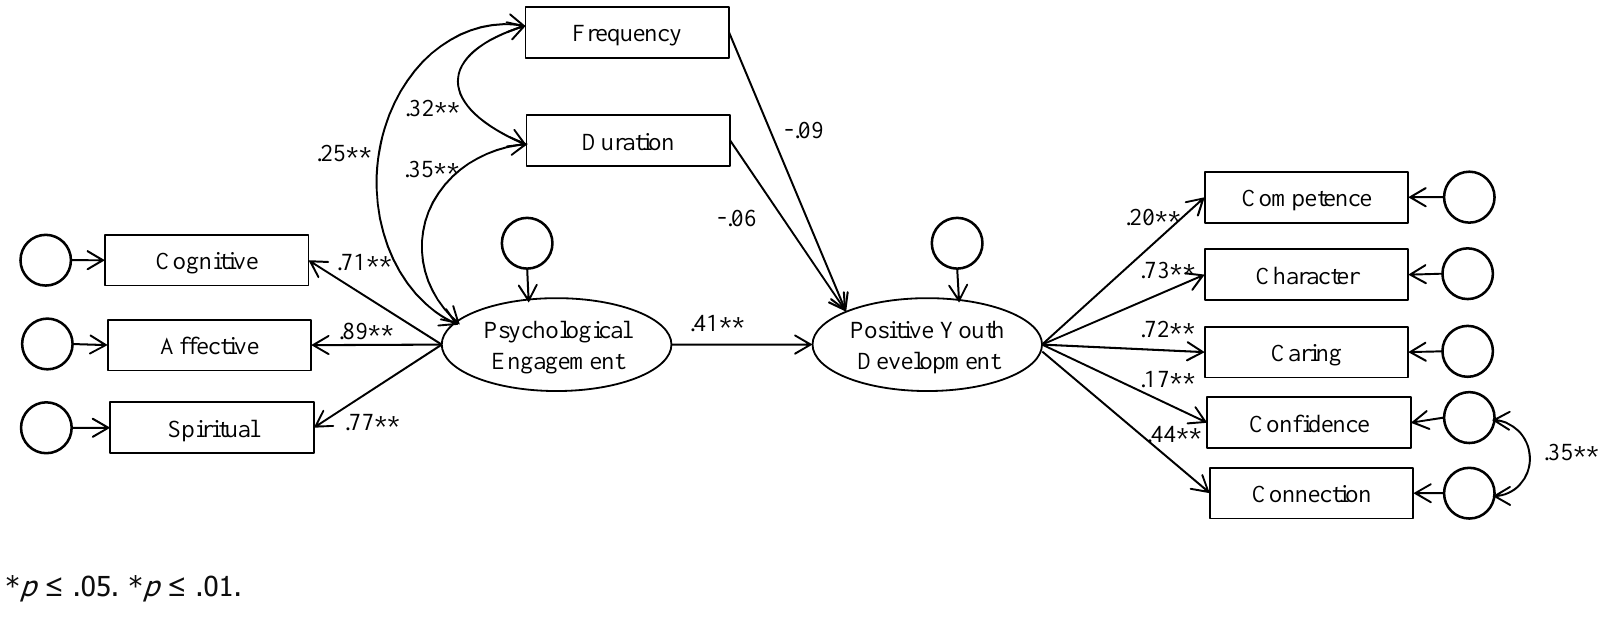
Figure 1. SEM Model of Psychological Engagement and Behavioral Participation Predicting Positive Youth Development *p ≤ .05. *p ≤ .01. * p ≤ .05. * p ≤